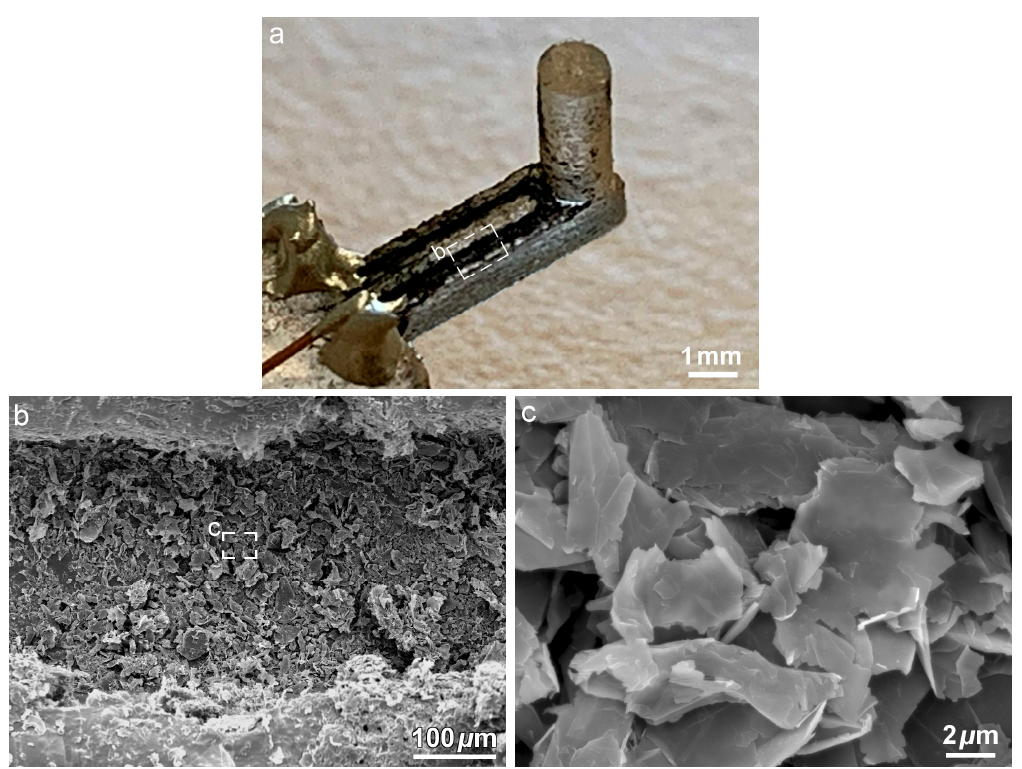
Figure 3. Micrographs of sensor structure with graphene infused into the microchannel: ( a ) optical micrograph of the developed sensor, ( b ) SEM image of GN inside the microchannel and ( c ) high magnification SEM image showing the morphology of GN sensing elements.